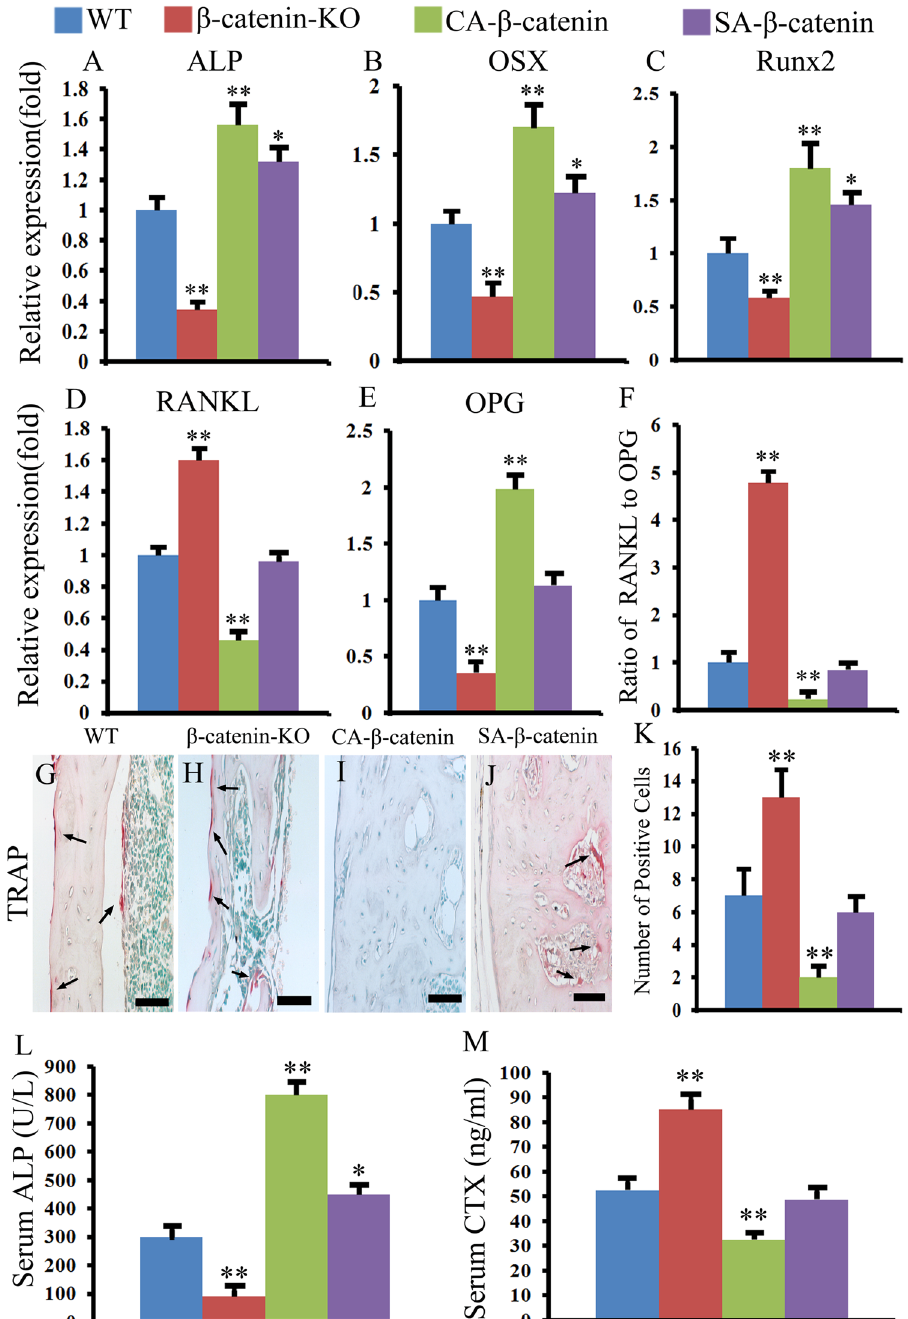
Figure 4. Slight activation of β -catenin in the remodeling phases enhanced bone formation without obvious hindering bone resorption. ( A – F ) The ALP, OSX, Rux2, RANKL, OPG mRNA expression levels and RANKL/ OPG ratio in WT, β -catenin-KO, CA- β -catenin and SA- β -catenin mice. ( G – K ) Representative TRAP staining of tibia fracture calluses in each group and the quantitative data. ( L and M ) The serum concentration of ALP and CTX in each group. The values are expressed as the means ± SDs. * p < 0.05, ** p < 0.01 (Scale bar = 25 µ m in G – J , n =